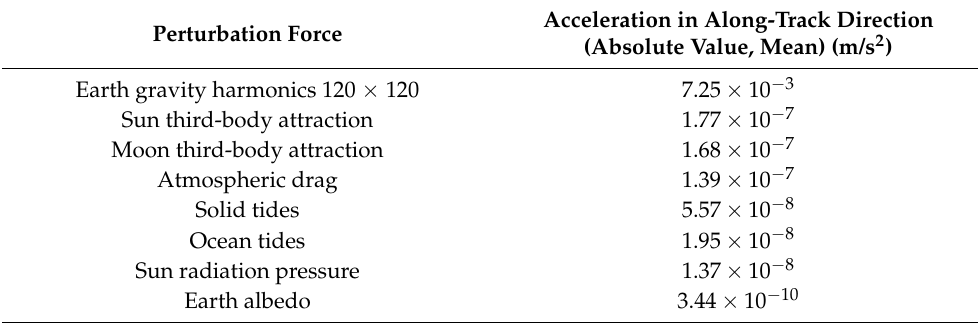
Table 2. Overview of perturbation forces on TUBIN, averaged over a 4 day period with F 10.7 = 120, C D = 2.2, and C R = 1.0 in nadir